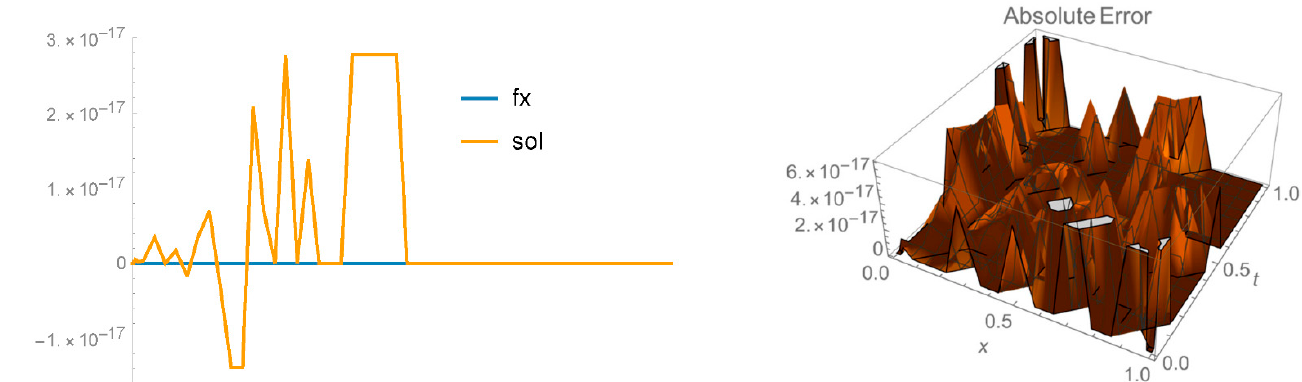
Figure 2. The illustrations of the contrast between precise (sol) and approximate ( fx ) results are presented when t = x is replaced in the solutions of the Equation (14), on the left-hand side of the figure. This graph shows accuracy in the single variable x . On the right-hand side of the figure, 3D plot of the absolute error between both solutions is also given over the intervals 𝑥 ∈ [0,1] and 𝑡 ∈ [0, 1] . The graphs show the high precision of the numerical results. This kind of accuracy occurred when n = 1-degree polynomials were used in variables ( x , t ) for approximating the solution of Equation (14).